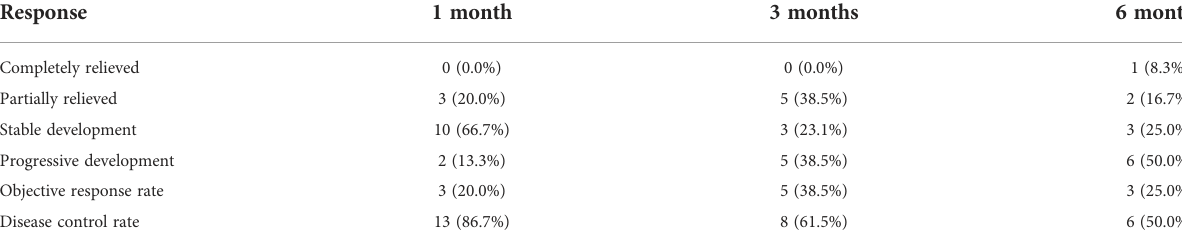
TABLE 3 Treatment responses of the study patients.